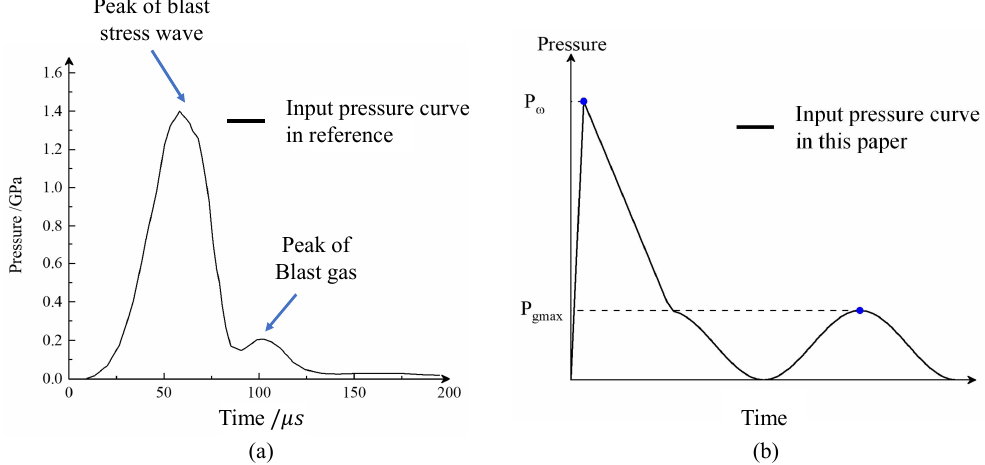
Figure 3. Explosion load with the form of dynamic and quasi-static: ( a ) pressure curve suggested in [34]; ( b ) pressure curve used in this